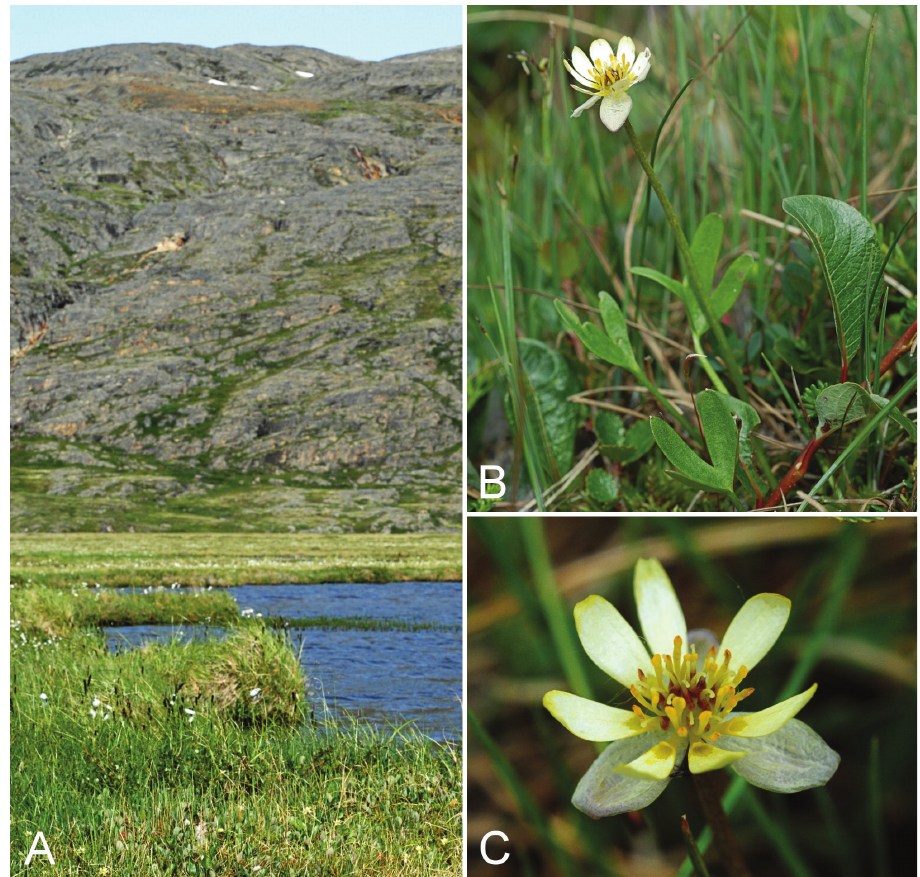
Figure 18. Coptidium × spitsbergense : A habitat B habit C flower, Saarela et al. 2419 . Photographs by L.J.